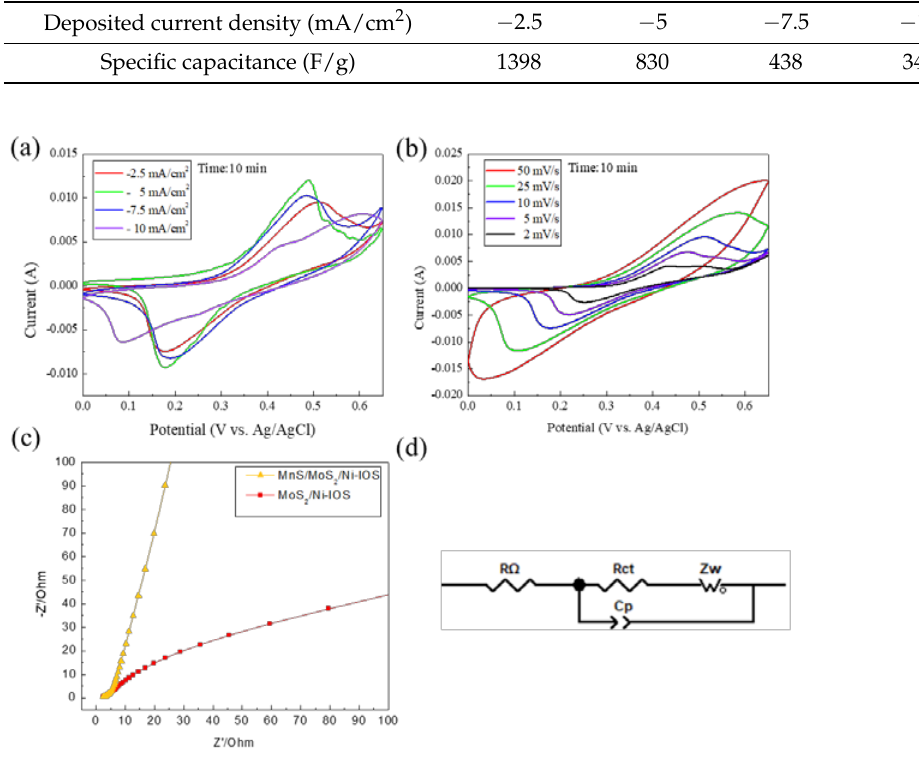
Figure 9. ( a ) CV test curves of the MnS/MoS 2 /Ni-IOS microelectrode samples with different electrodeposition current densities for a 10 min deposition time, where the scan rate was 10 mV/s, and the current densities were − 2.5 mA/cm 2 , − 5 mA/cm 2 , − 7.5 mA/cm 2 , and − 10 mA/cm 2 , respectively. ( b ) CV curves of the MnS/MoS 2 /Ni-IOS microelectrode samples at different scan rates, using the − 2.5 mA/cm 2 and 10 min electrodeposition parameters, the scan rates were 50 mV/s, 25 mV/s, 10 mV/s, 5 mV/s, and 2 mV/s, respectively. ( c ) Nyquist plots of the MoS 2 /Ni-IOS and MnS/MoS 2 /Ni − IOS microelectrode samples, and ( d ) the equivalent circuit used for fitting the impedance spectra of the MnS/MoS 2 /Ni-IOS microelectrode